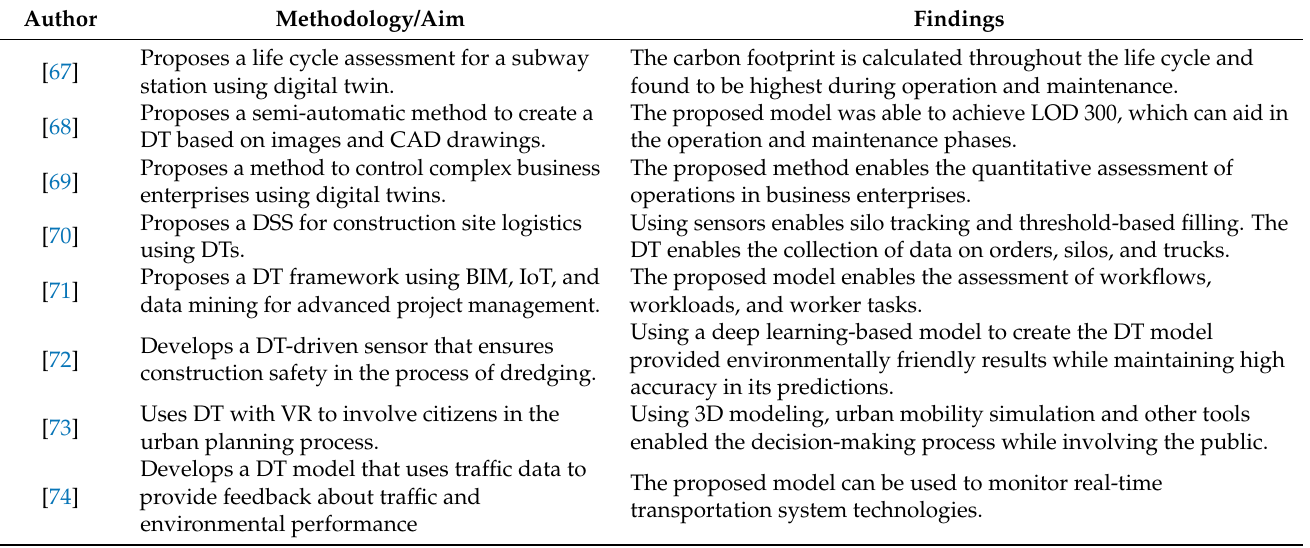
Table 6. Miscellaneous Digital Twin